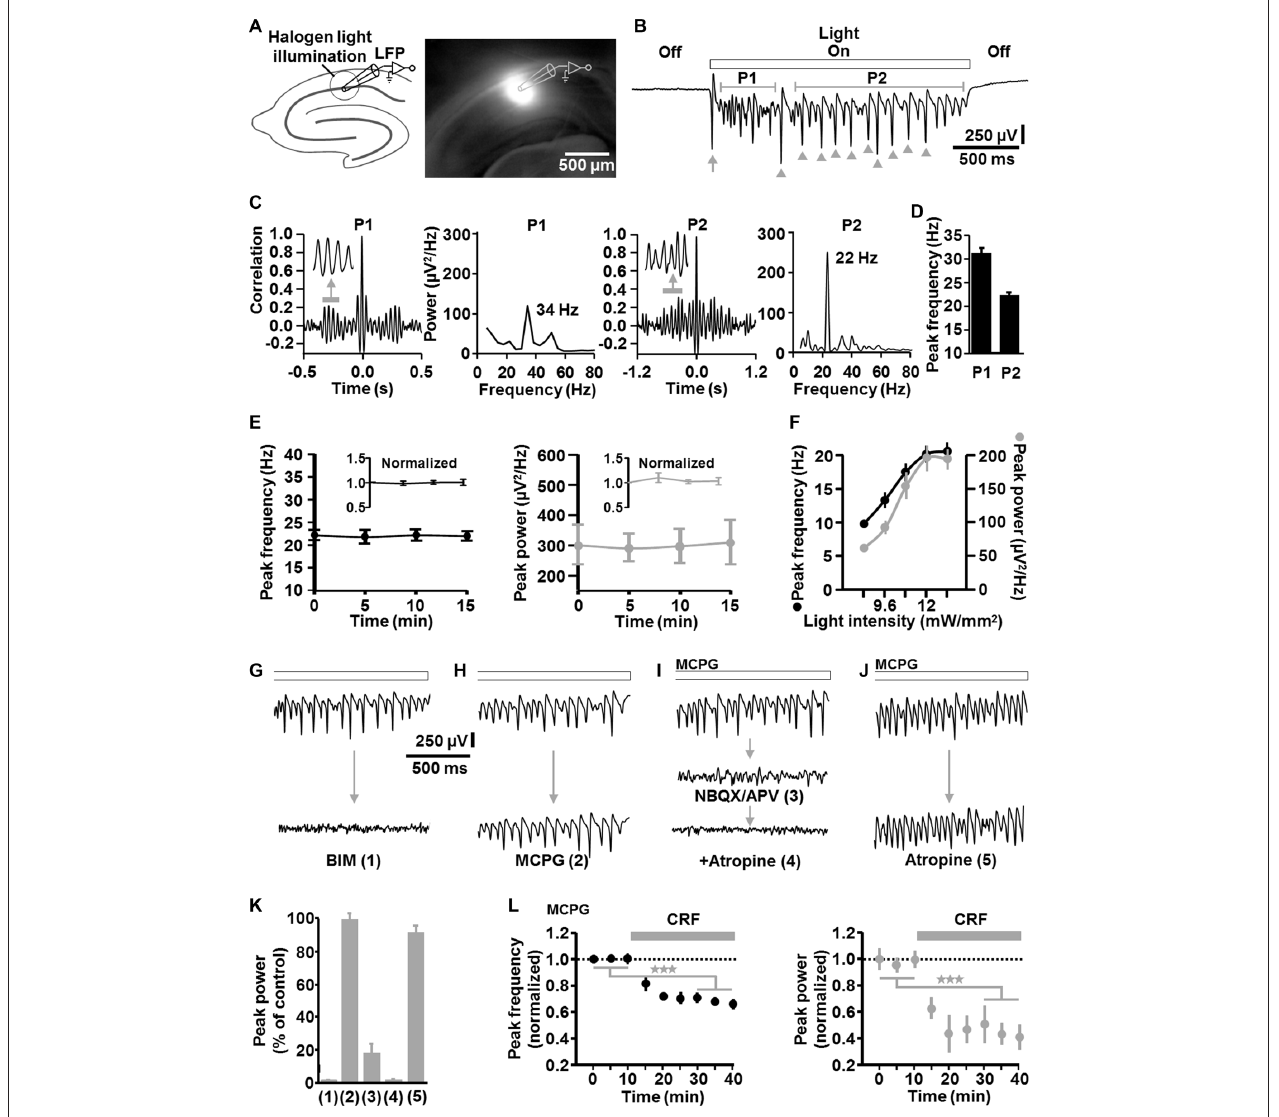
FIGURE 2 | Descriptive properties and pharmacological characteristics of optogenetically induced fast CA1 network oscillations in brain slices from NEX-Cre-ChR2 mice. (A) Experimental setting and photograph illustrating the illumination of a circular portion of area CA1 with halogen light (12 mW/mm 2 ). (B) Representative recording trace depicting the oscillatory network activity during ChR2 activation (arrow and arrow heads mark(s) clearly visible initial and subsequent population spike(s) generated by CA1 pyramidal neurons; P1, period 1; P2, period 2). (C) Autocorrelograms and power spectra for P1 and P2 of the rhythmic network activity shown in (B) . (D) Average data from spectral analyses ( n = 14 from 7 animals). (E) The peak frequency and peak power of the CA1 oscillations remained stable over repeated evocations ( n = 8 from 4 animals). (F) Relationship between halogen light intensity and peak frequency/peak power of the CA1 oscillations ( n = 8 from 6 animals). Light intensities above 12 mW/mm 2 did not further increase both parameters of the oscillations. Note the increase of the frequency with increasing spectral power, which is typical for P-I oscillations. (G–K) Impact of the GABA A receptor antagonist bicuculline methiodide (BIM; n = 7 from 5 animals), the group I/II mGlu receptor blocker methylenecyclopropylglycine (MCPG; n = 3 from 3 animals), the ionotropic glutamate receptor antagonists NBQX and APV ( n = 5 from 4 animals), and the mACh receptor blocker atropine ( n = 4 from 3 animals for atropine alone) on the light-induced oscillations (all receptor blockers were administered at well proven maximal antagonizing concentrations). For each pharmacological condition, recordings were made 10 min after addition of the drug(s) to the extracellular solution and representative recording traces are shown in (G–J) . Quantifications of the pharmacological effects are graphed in (K) , with numbers 1–5 corresponding to the numbers in brackets in (G–J) . (I,J) Extracellular solution contained MCPG. (L) Corticotropin-releasing factor (CRF) impaired the light-evoked CA1 oscillations. After recording a stable baseline, human/rat CRF was bath applied at 125 nM to slices. This treatment led to a marked decrease in the peak frequency and peak power of the oscillations ( n = 7 from 4 animals, (cid:70)(cid:70)(cid:70) p < 0.001, one-sample t test). Extracellular solution contained